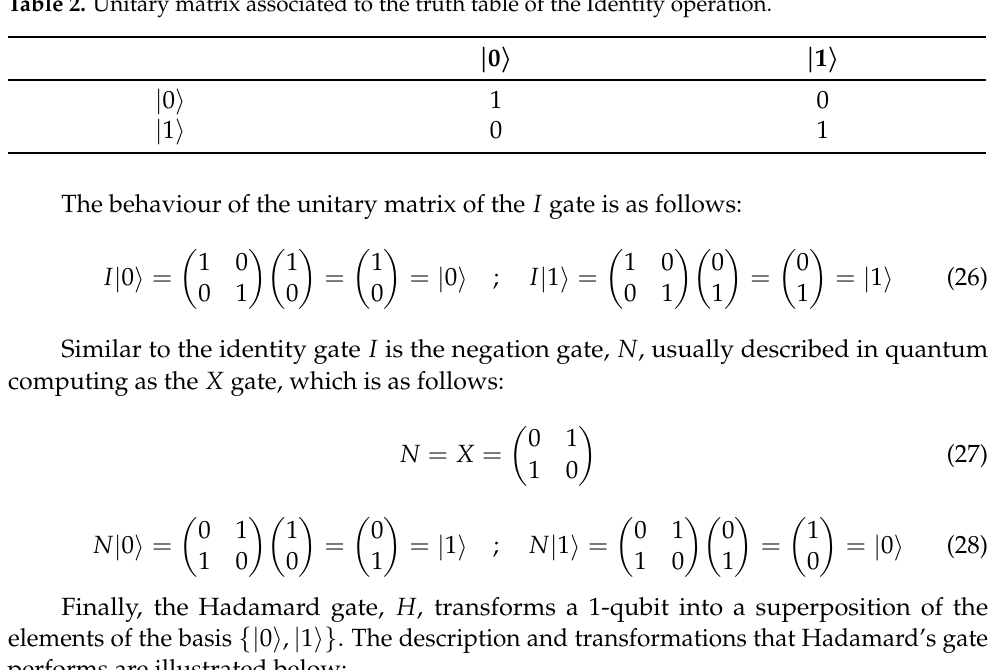
Table 2. Unitary matrix associated to the truth table of the Identity